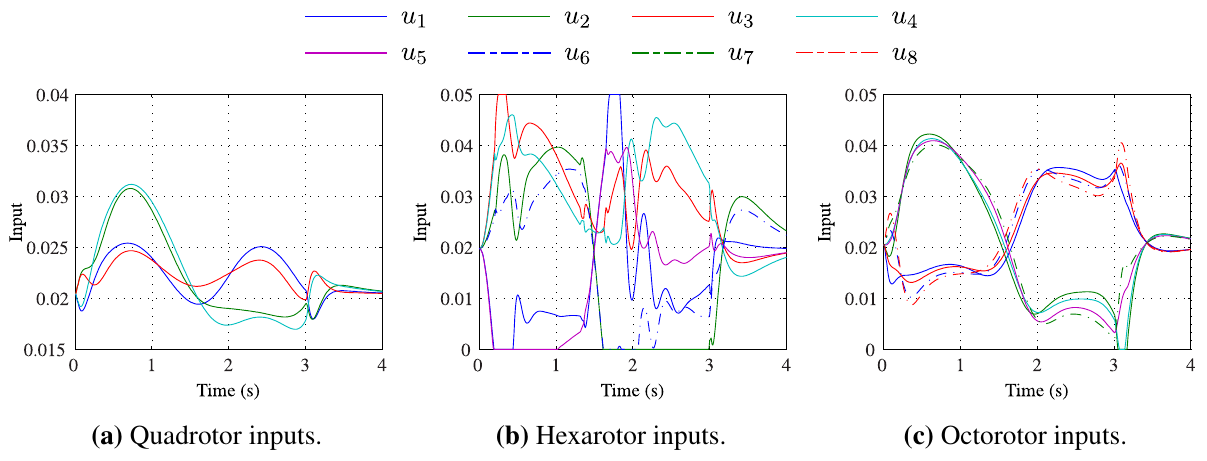
Figure 16. Motor input histories for each configuration while tracking a fast four-dimensional